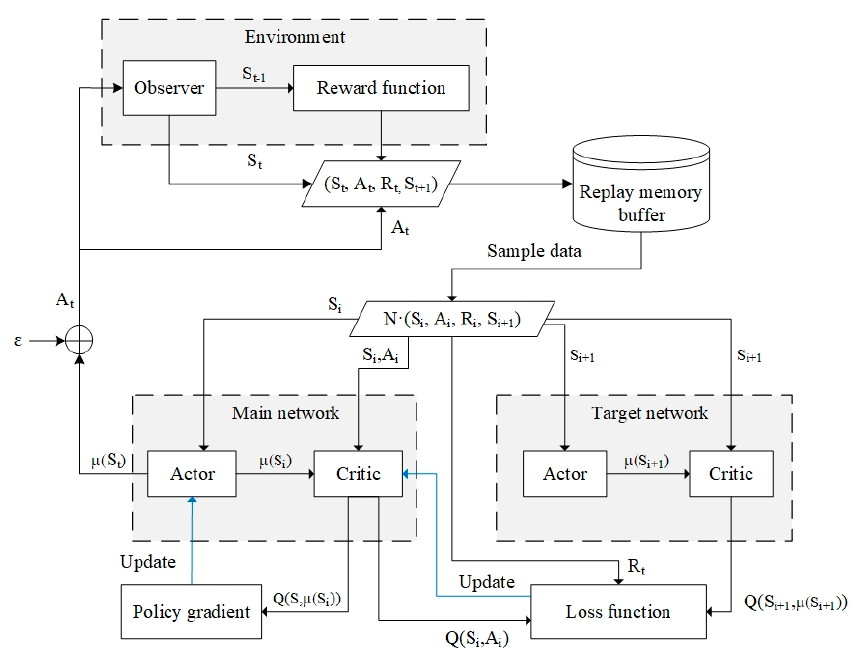
Figure 2. Schematic diagram of the DDPG agent. Figure 3. Schematic diagram of the DDPG